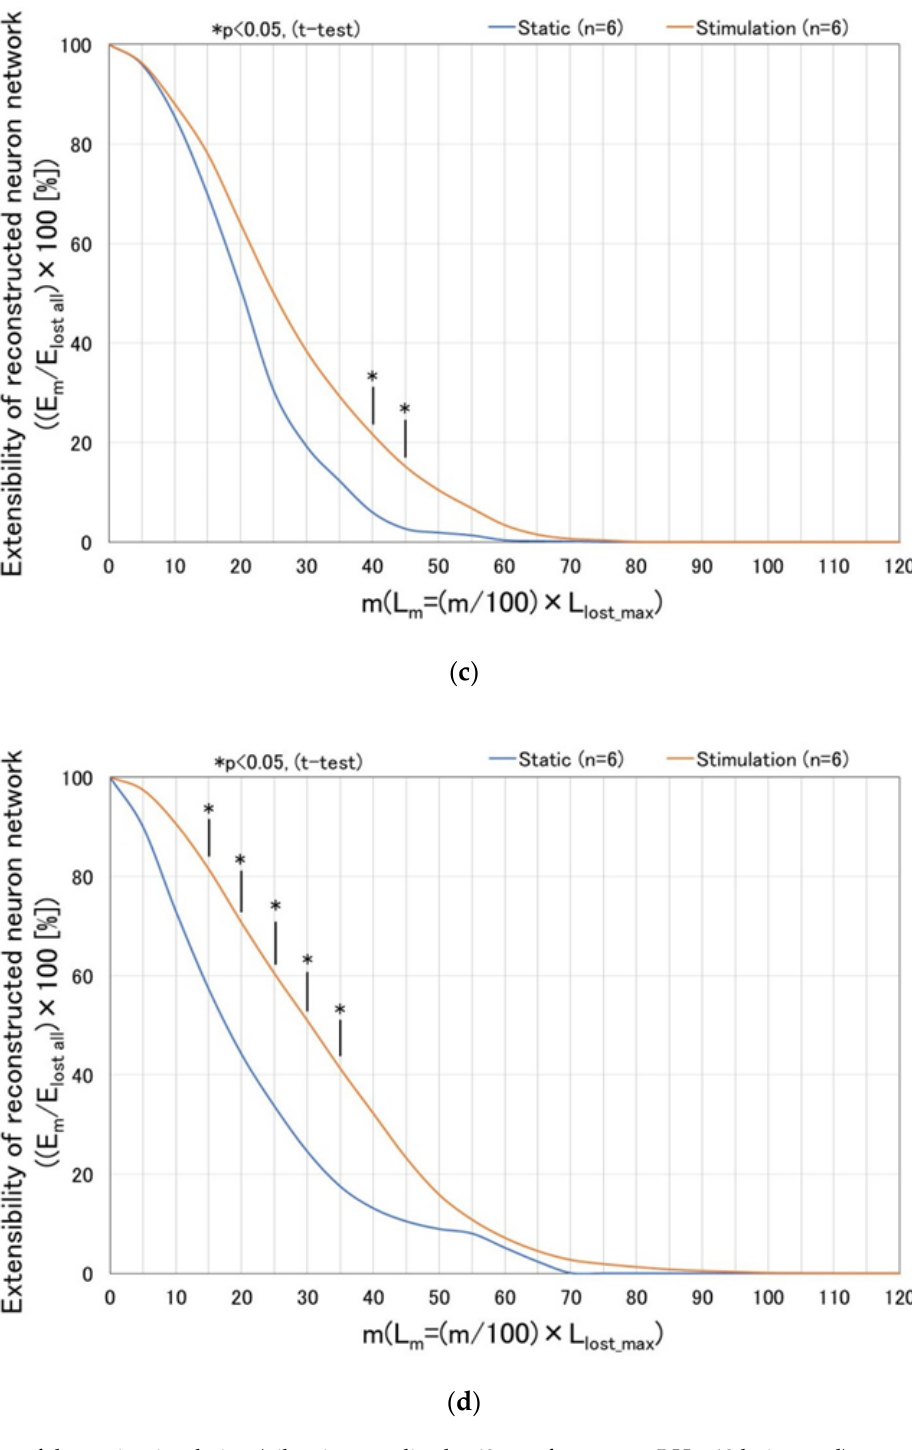
Figure 10. Effect of dynamic stimulation (vibration amplitude: 60 µ m, frequency: 5 Hz, 12 h. interval) upon extensibility of the reconstructed neurites [=(E m /Elost all) × 100] with respect to the value of m (indicating location line until which the neuronal pixels are counted for) and the culture time. Results are computed based on the parameters defined in Figure 9. Significant differences are observed between the statically cultured damaged neurons and the dynamically stimulated ones as the culture time increases, such as on day 7, 9, 11 (or 2, 4, 6 days after cutting damage), respectively. ( a ) Day 5 (initial state, just before cutting damage); ( b ) Day 7 (2 days after cutting damage); ( c ) Day 9 (4 days after cutting damage); ( d ) Day 11 (6 days after cutting